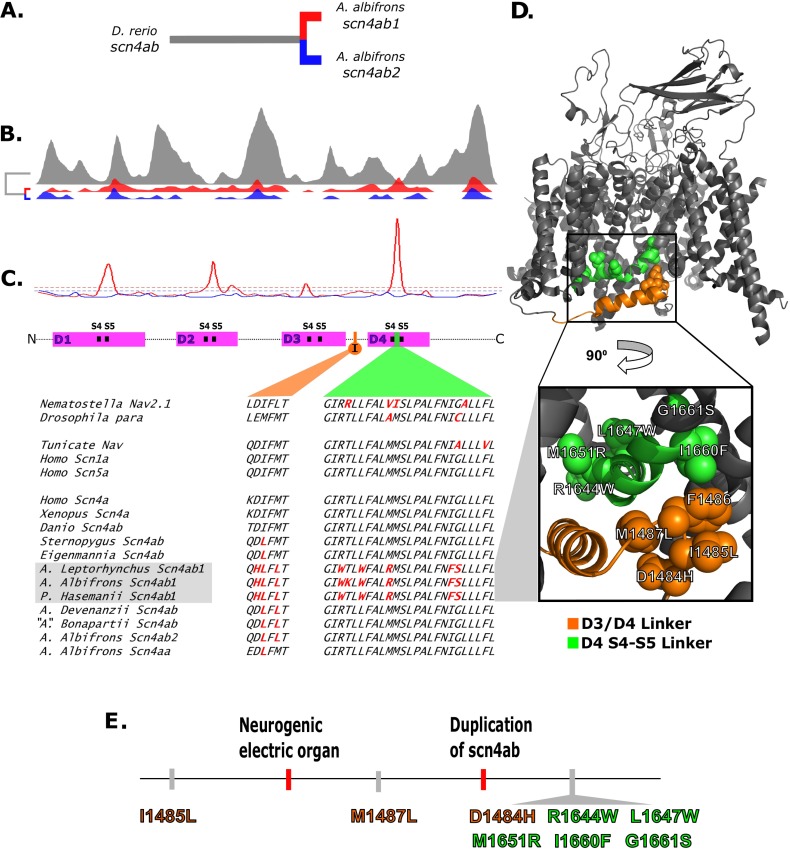
Relative density of amino acid replacements in scn4ab1 and scn4ab2.(A) The orthologs used in the analysis, where the 2 paralogs in A. albifrons were compared to the much more distantly related ortholog in D. rerio. (B) Density plots of amino acid substitutions along the sodium channel (N to C) that are specific to each gene. (C) The relative density of substitutions specific to scn4ab1 and scn4ab2 (red and blue, respectively). The relative density is the ratio of substitution density at each position in the protein to the added density in the other 2 branches. The dotted lines show conservative significance thresholds for the same relative density measure from simulating random distributions of the amino acid substitutions in the 3 gene sequences. The 4 domains of a typical sodium channel are shown as magenta rectangles, with the transmembrane domains near the highest peak densities indicated in the intracellular linker between S4 and S5 (S4–S5) and the inactivation particle indicated with an orange circle and denoted “I.” The bottom protein alignments are of the inactivation particle (orange) and one of the inactivation receptors in domain 4 (green) that shows the highest relative substitution signal in scn4ab1. Scn4ab1 exhibits several amino acid substitutions that are highly conserved among chordates in both protein structures. Alignments of all human and zebrafish Nav channels are shown in S6 Fig. (D) Structural view of the Nav1.4-β1 complex from electric eel with positions of Apteronotid substitution represented as spheres [42]. Residue numbering is from the human cardiac sodium channel, hNav1.5, the background into which mutations were made for electrophysiology in this study. The inset is a magnified view of the putative binding site for the IFM inactivation particle in the D3–D4 loop. (E) Evolutionary sequence of amino acid replacements in the inactivation machinery. C, carboxy-terminus; hNav, human voltage-gated sodium; N, amino-terminus; F, phenylalanine; I, isoleucine; M, methionine.